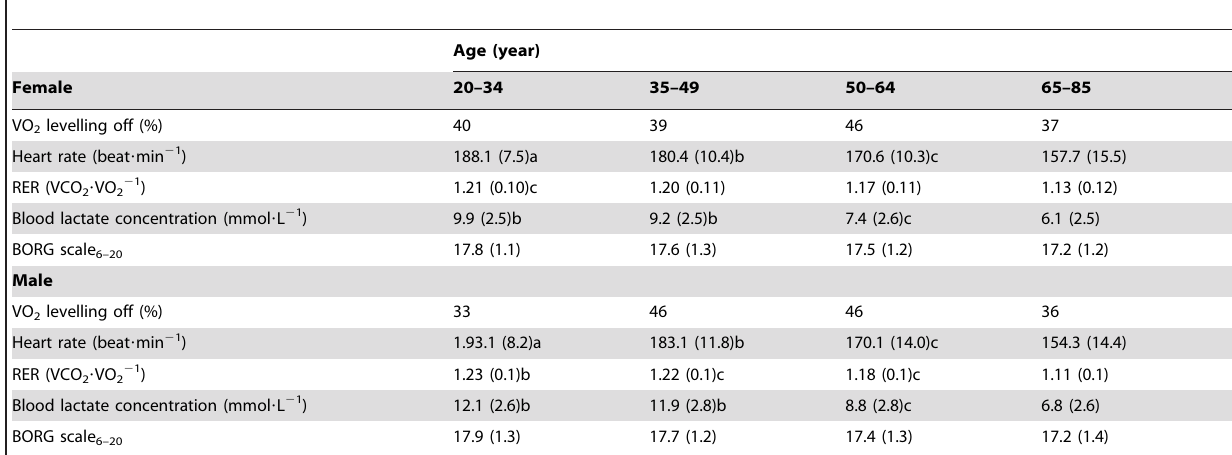
Table 2. End criteria variables during maximal exercise by 15-year age cohort for female and male